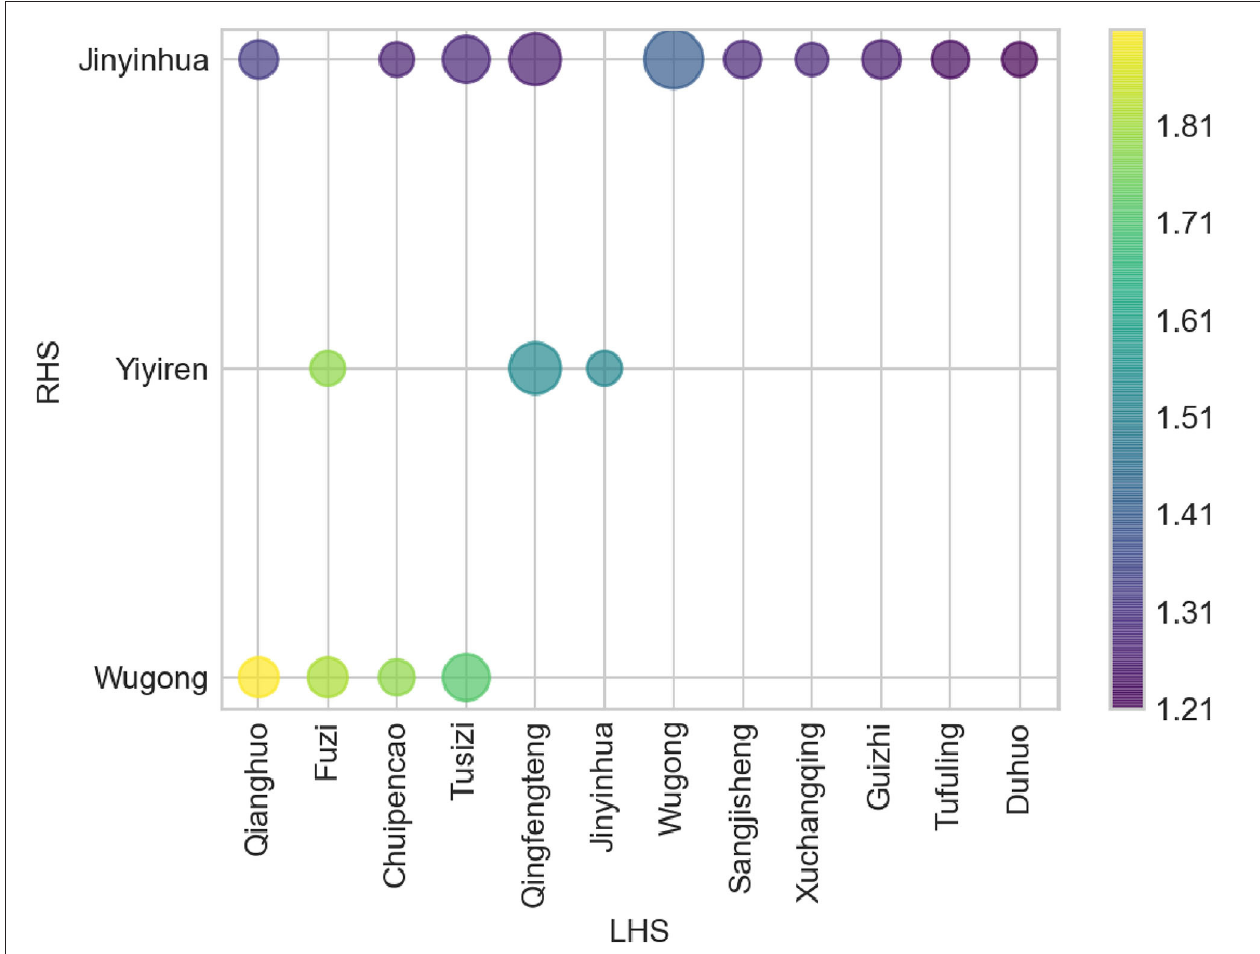
FIGURE 7 | The bubble diagram of the grouping matrix for the 17 association rules based on the second-order association between different herbs. ( X -axis: “LHS”; Y -axis: “RHS”; Size: “Support”; Color: “Lift.” Data were analyzed by using Apriori association rules and visualized by Python software).